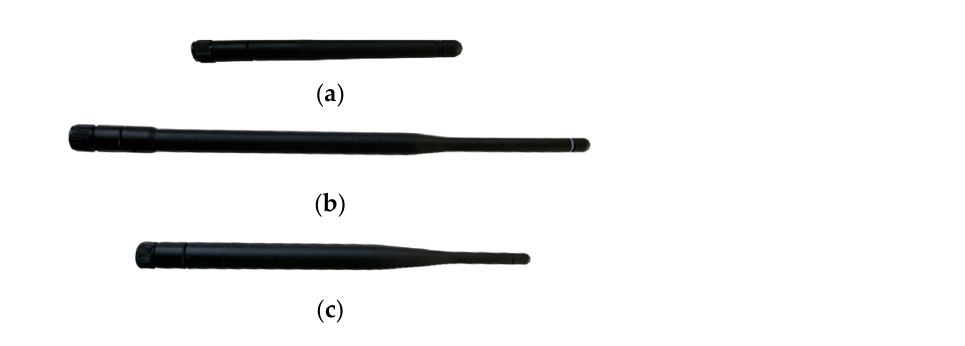
Figure 4. Off-the-shelf benchmark antennas ( a ) Eightwood Antenna ( b ) Mouser ( c ) Things Network Gateway.